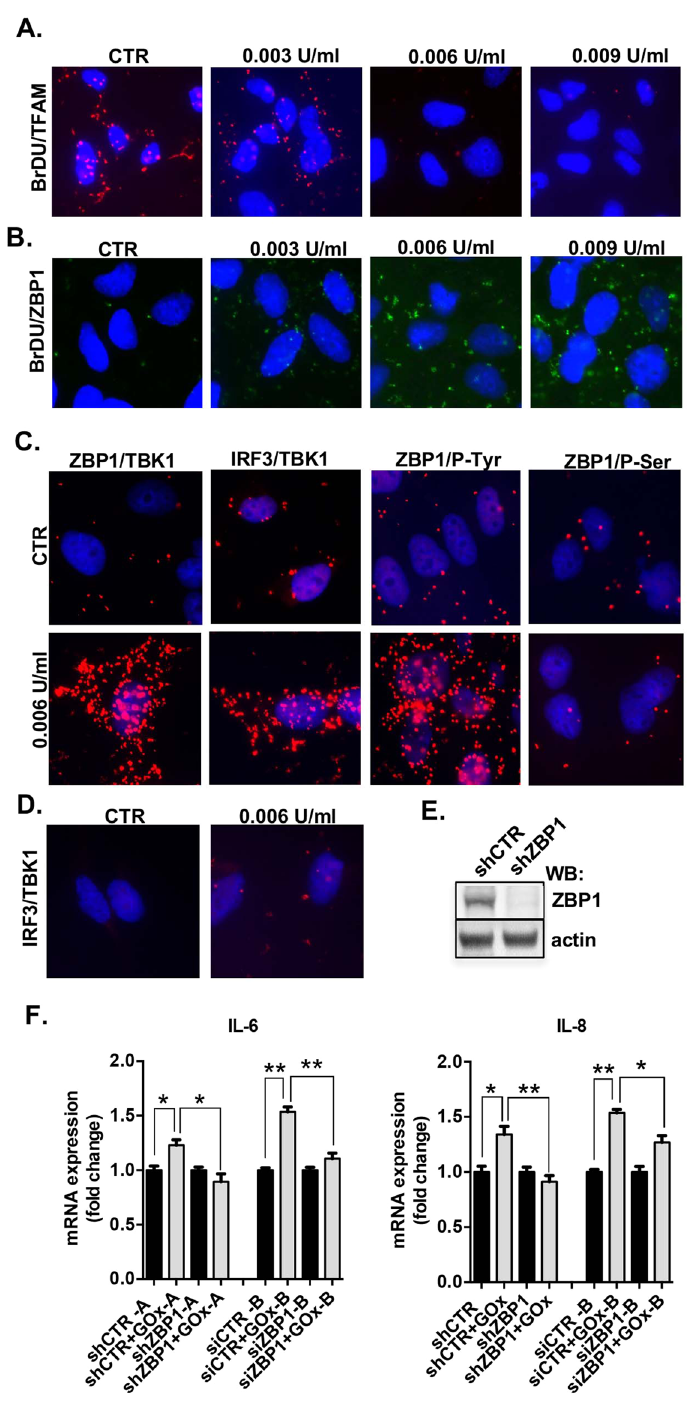
Figure 3. Damaged mitochondrial DNA activates ZBP1/TBK1/IRF3 signaling pathway. Interaction between BrDU- labelled mtDNA and TFAM ( A ) and BrDU-labelled mtDNA and ZBP1 ( B ) in control and GOx-treated cells at 1 h. ( C ) Interaction between ZBP1/TBK1, IRF3/TBK1, ZBP1/P-Tyr and ZBP1/P-Ser in control and GOx-treated cells at 1 h. ( D ) Interaction between IRF3/TBK1 in pre-treated with 3 μ M of CsA in GOx-treated BEAS 2B cells. ( E ) Level of ZBP1 depletion, shown by Western blotting. ( F ) Expression of IL-6 and IL-8 in unstressed and GOx-treated (0.006 U/ ml for 1 h) in control and ZBP1-depleted BEAS2B cells. Representative images of n = 3 independent experiments are shown. Data represent average ± SEM of n = 5 biological replicates. * p < 0.05 vs .